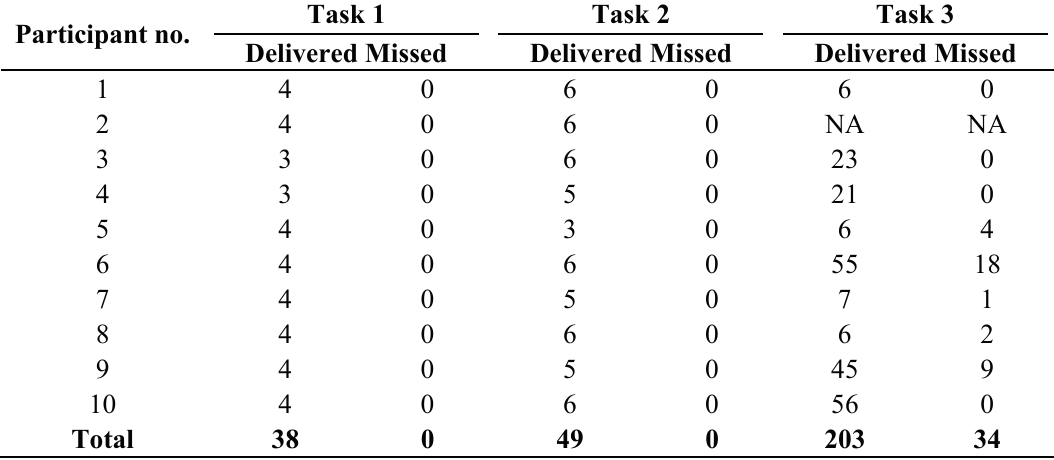
Table 3. Number of prompts delivered to each participant during each of the three tasks of the